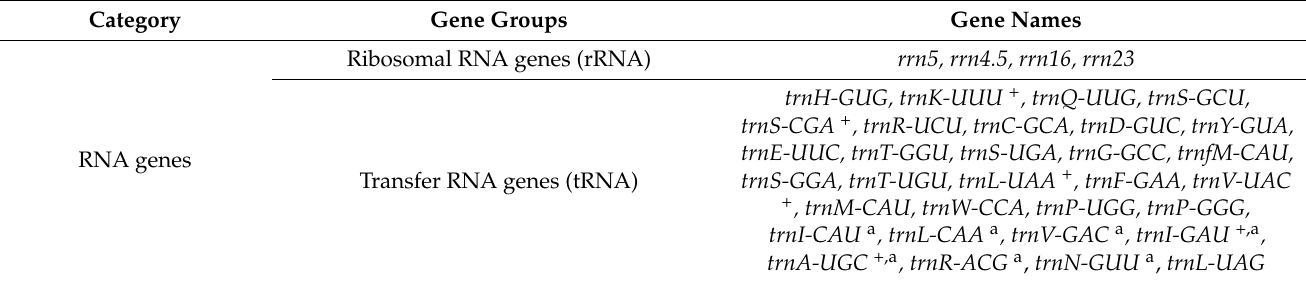
Figure 1. Chloroplast genome maps of the four Capparaceae species. Genes drawn inside the circle are transcribed clockwise, while those outside the circle are transcribed counter-clockwise. The inner dark gray circle corresponds to GC content and the inner light gray circle corresponds to the AT content. Different colors are used as a representation of distinctive genes within separate functional groups. Table 2. Gene contents in the chloroplast genomes of Cadaba and Maerua species.